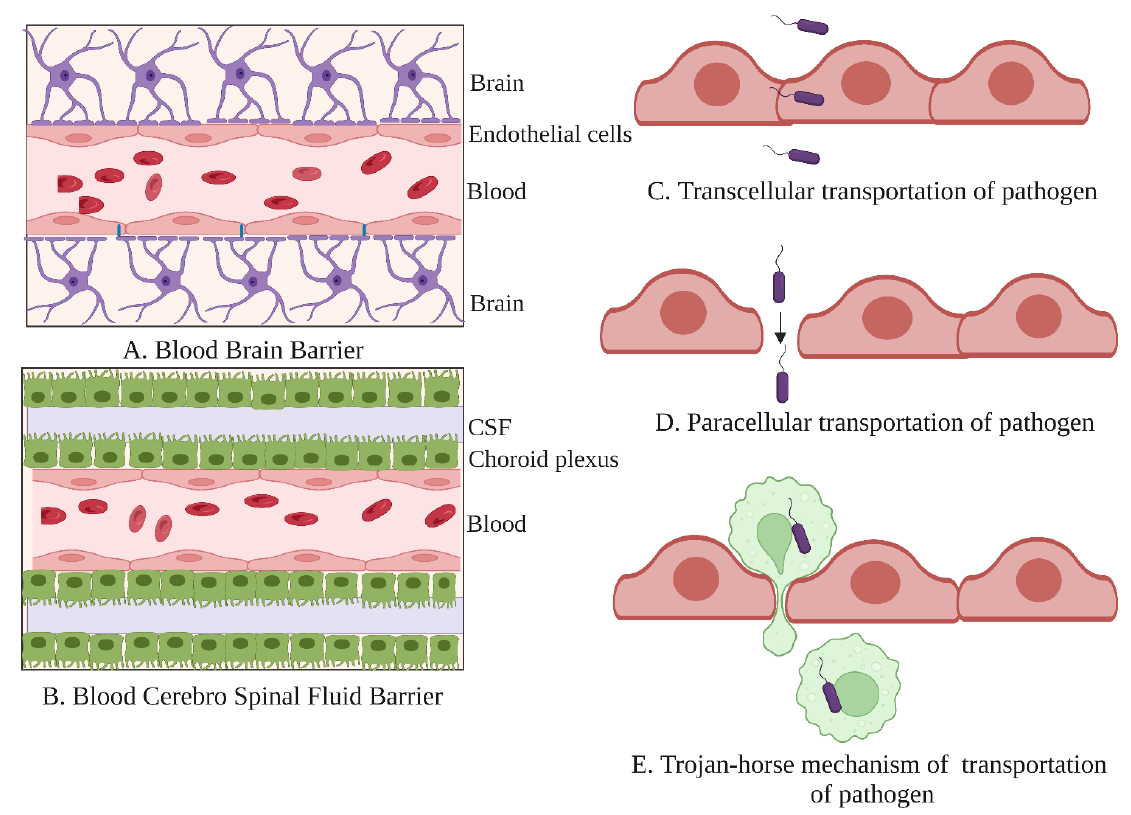
Figure 2. Barriers of the central nervous system. ( A ) The blood–brain barrier (BBB) is lined with tightly packed endothelial cells; ( B ) The blood–cerebrospinal fluid (CSF) barrier (BCSFB) is lined with a layer of endothelial cells and choroid plexus epithelial cells comprising CSF in between the choroid plexus epithelial cell layers. The possible means of bacterial entries, such as ( C ) transcellular transportation; ( D ) paracellular transportation; and ( E ) Trojan-horse mechanism. The illustration was created with BioRender.com.